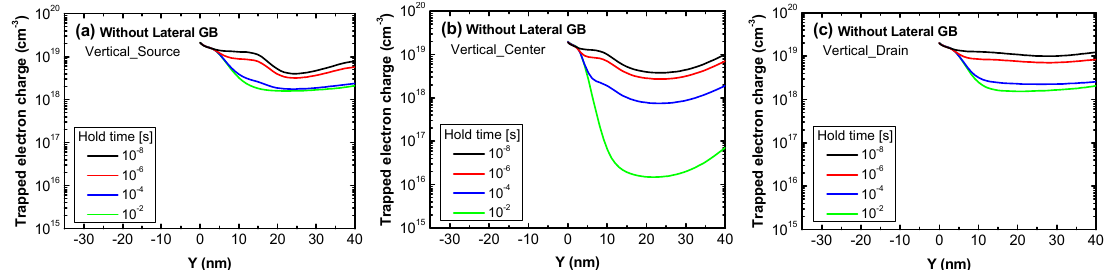
Figure 10. The trapped electron charge in the Read “0” operation of poly ‐ Si 1T ‐ DRAM devices that have no lateral GB as a function of the position within a vertical GB. The lines in each figure represent varied hold times to show their effect on the trapped electron charge. The devices are ( a ) Vertical_Source, ( b ) Vertical_Center and ( c ) Vertical_Drain.